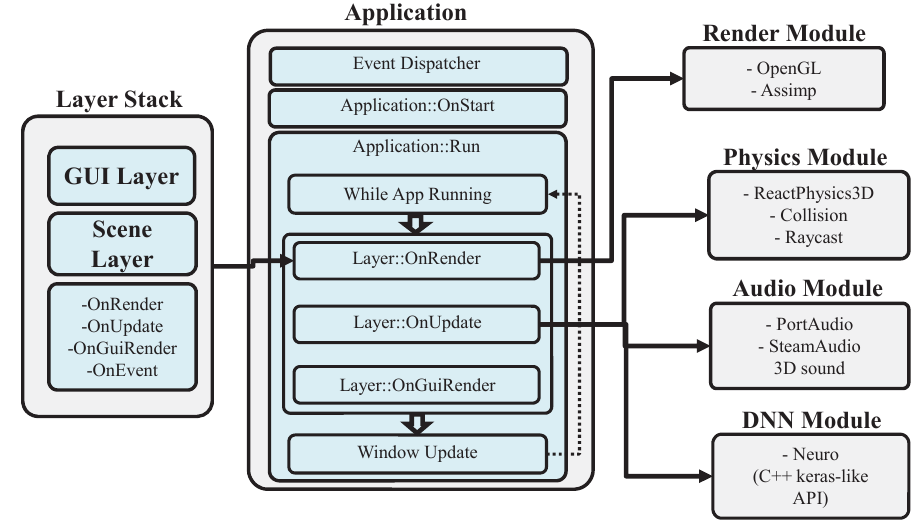
Figure 1. The overall architecture of our game